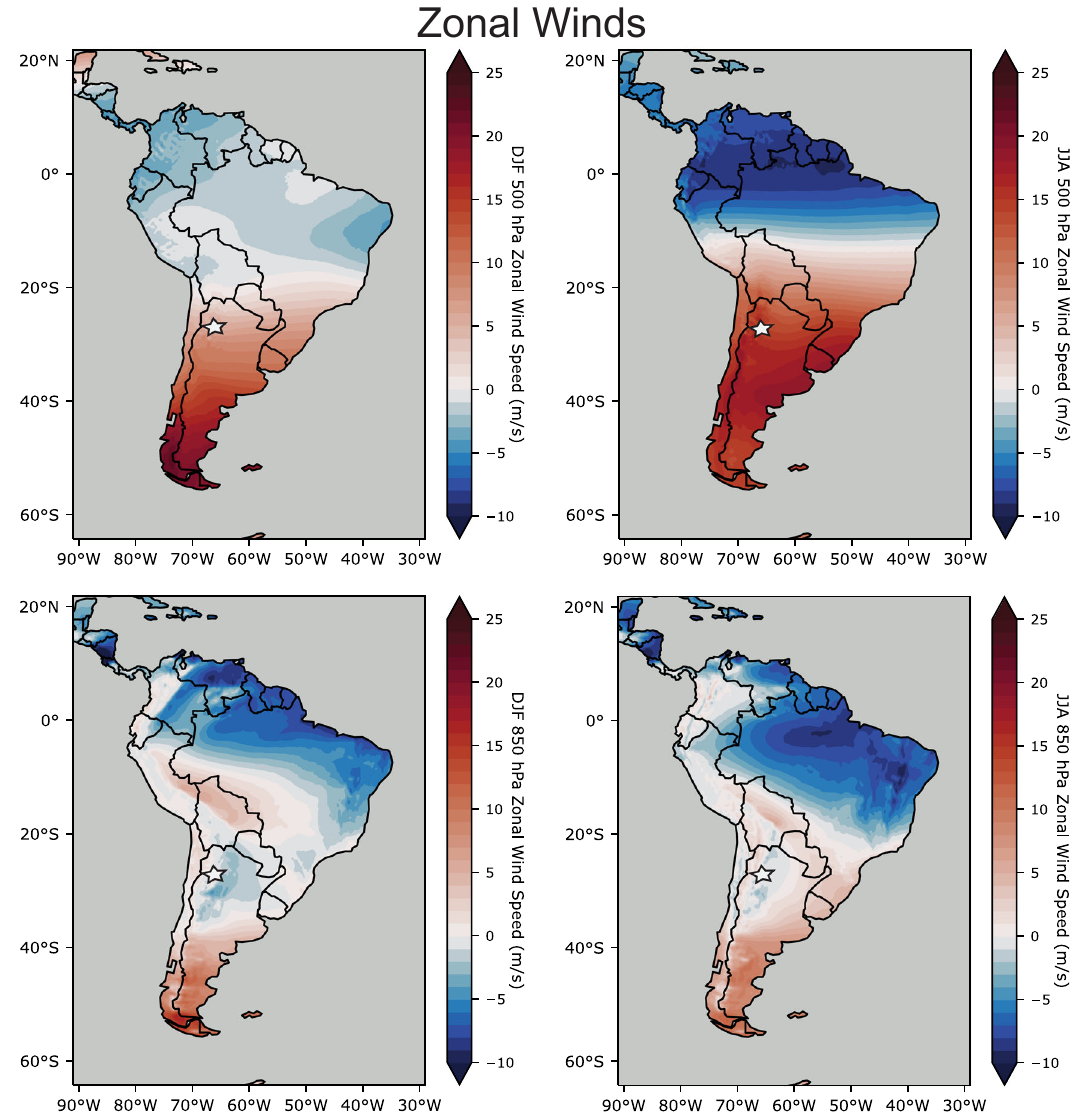
Fig. 3 The zonal components of wind at 500 hPa and 850 hPa for 1979 – 2021. Data from the ERA5 Reanalysis product 73 . Positive values (red) denote westerly winds, whereas negative values (blue) denote easterly winds. The white star indicates the fi eld location in Tafí del